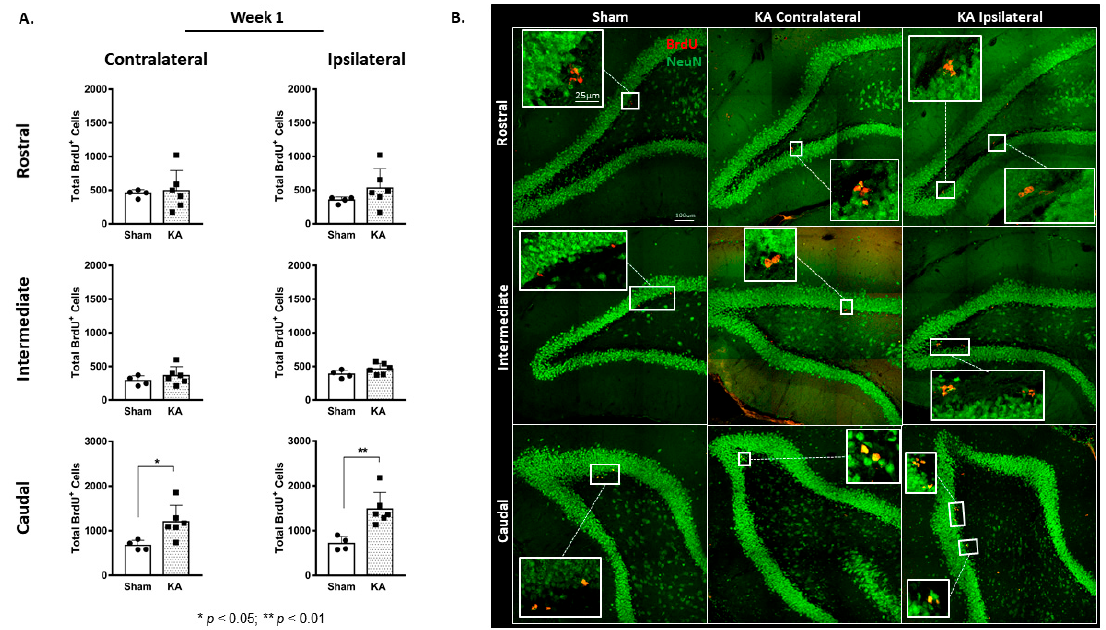
Figure 3. Spatial distribution of increased cell proliferation in the ipsilateral and contralateral dentate gyrus at week 1 following continuous micro-perfusion of kainic acid into the AN. ( A ) The graphs illustrate the spatial distribution of the total number of BrdU-labeled cells in the contralateral and ipsilateral DG in the sham ( n = 4) and KA micro-perfused ( n = 6) rats. Determination of significance was made using two-tailed unpaired Student’s t -test. ( B ) Confocal images illustrating BrdU-labeled cells in the rostral, intermediate, and caudal segments of the DG in the sham and KA micro-perfused rats (ipsilateral and contralateral sides with reference to the injection site). Scale bar is 100 µm.